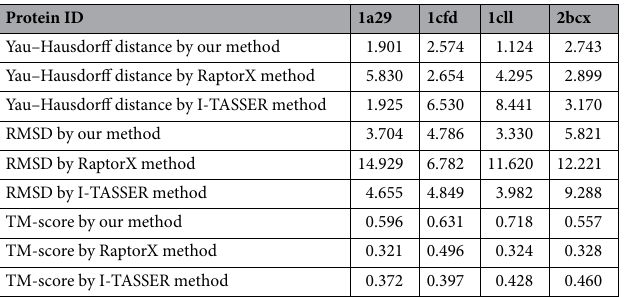
Table 2. Yau–Hausdorff distances, RMSD values and TM-score values between the empirically determined and predicted structures of the four proteins with the same amino acid sequence using our method and RaptorX